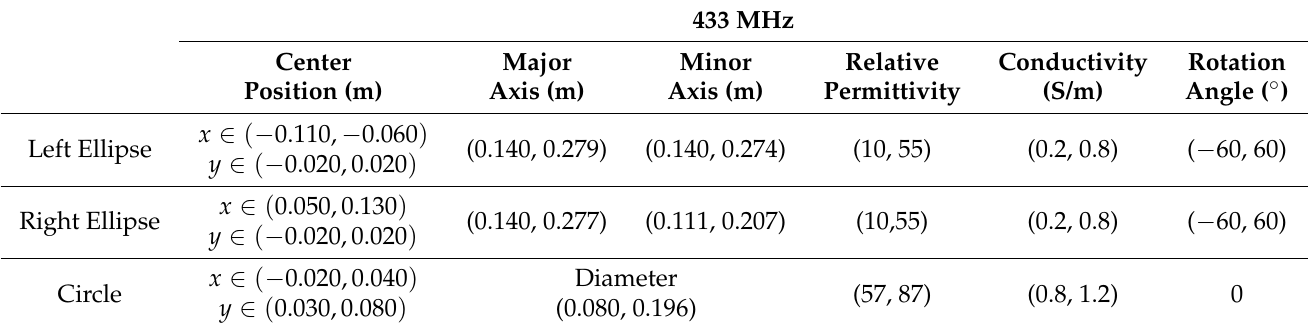
Table 2. Ranges of different parameters in training sets at 433 MHz and 915